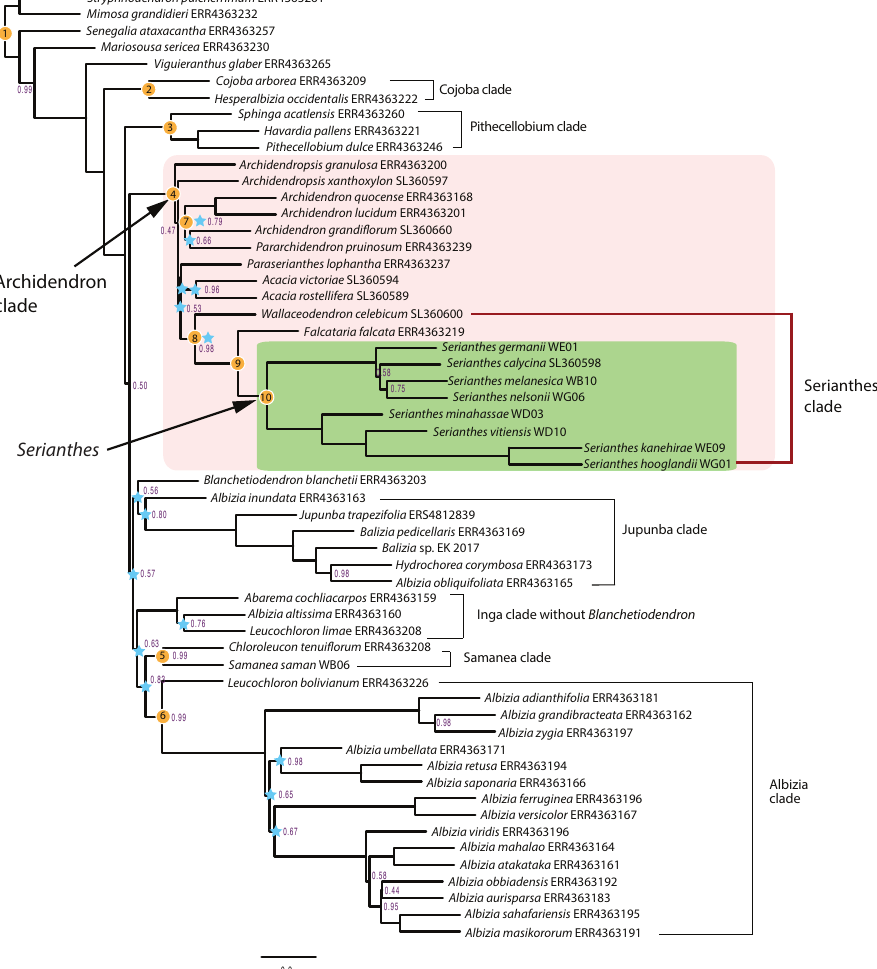
Figure 3. Phylogeny of the ingoid and Archidendron clades. ASTRAL species tree, based on 77 gene trees. Nodes of particular interest are labelled with numbered orange circles and are discussed in the text and Table 3. Unambiguously supported relationships shown with PP = 1 unless indicated at the nodes. Blue stars show nodes where a polytomy cannot be rejected by the data using the polytomy test (p ≤ 0.05). Clade names follow (Koenen et al. 2020), except for the Serianthes clade, which is newly recognised